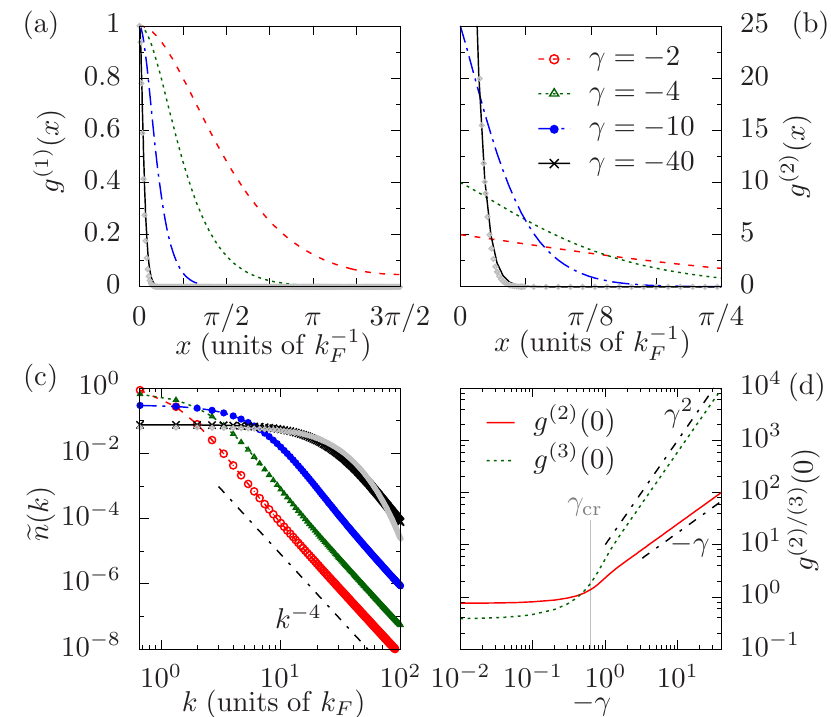
Figure 2: Ground-state correlation functions for N = 4 particles and interaction strengths γ = − 2, − 4, − 10, and − 40. (a) First-order correlation g ( 1 ) ( x ) . (b) Second-order correlation ( 2 ) ( 0 ) = 80, exceed the shown g ( 2 ) ( x ) . The local values for γ = − 40, g ( 2 ) ( 0 ) = 100 and g MF ) . Grey diamonds in (a)–(c) correspond to the mean- n ( k range. (c) Momentum distribution (cid:101) j field solution for γ = − 40. (d) Local second- and third-order correlation g ( 2 ) ( 0 ) and g ( 3 ) ( 0 ) , respectively, for a range of interaction strengths γ . Black dot-dashed lines indicate power-law scaling, proportional to − γ (lower line) and γ 2 (upper